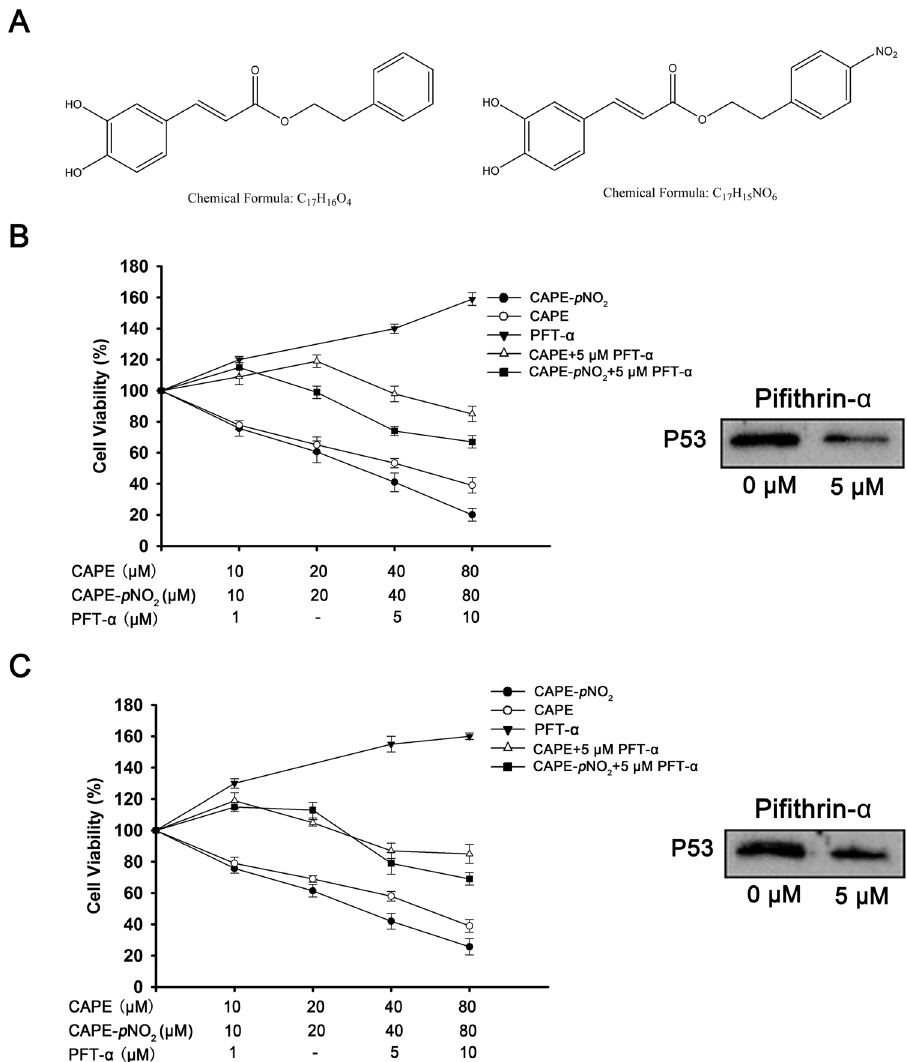
Figure 1. Chemical structure of the compounds used in the present study and results of the MTT assay. ( A) Chemical structure of CAPE and CAPE- p NO 2 . HT-29 cells (B) and HCT-116 cells (C) were treated with CAPE and CAPE and CAPE- p NO 2 for 48 h, and the expression of P53 after treatment by PFT- α . Values represented the means ± SD from three independent experiments, and error bars represented the STDEV